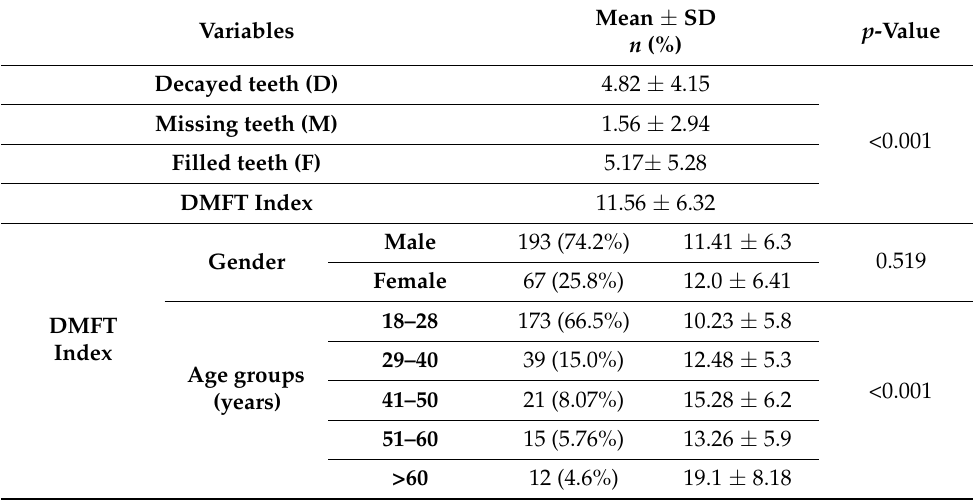
Table 5. The overall mean of decayed teeth, filled teeth, missing teeth and DMFT index and its association with age groups and